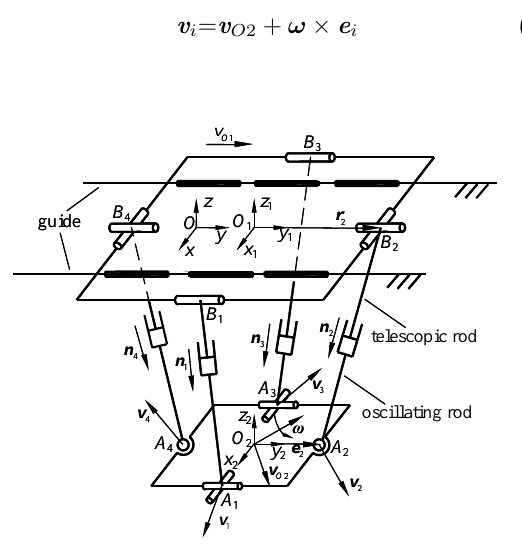
Figure 6: The velocities of the 5-DOF GHMT